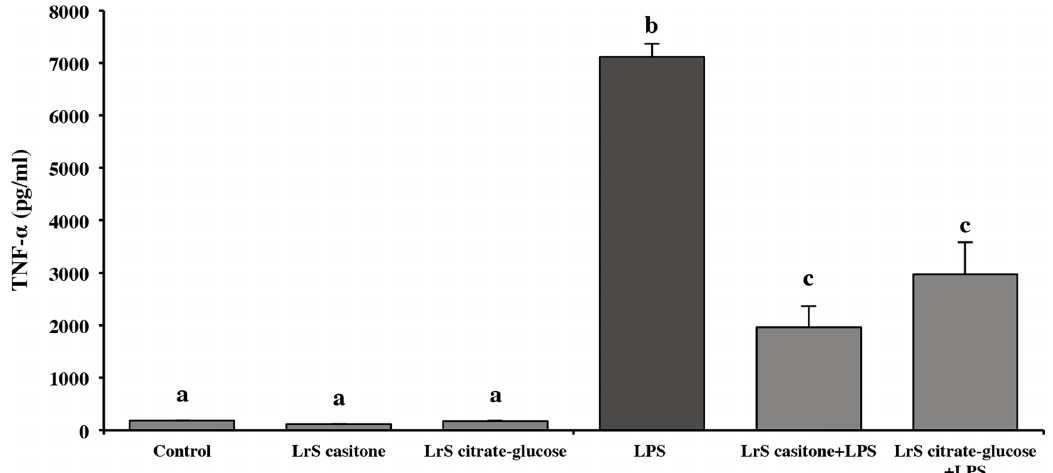
Fig 6. Effect of LrS on TNF- α production by RAW 264.7 macrophages. LrS production by bacteria grow in PETG medium (late exponential growth phase, pH-uncontrolled culture) was evaluated in casitone medium and sodium citrate buffer, and their anti- inflammatory effect was checked on LPS challenged RAW cells. TNF- α production was measured in culture supernatants. Data shown are a representative result of three independent experiments. Values not sharing the same letter were significantly different ( p -value <